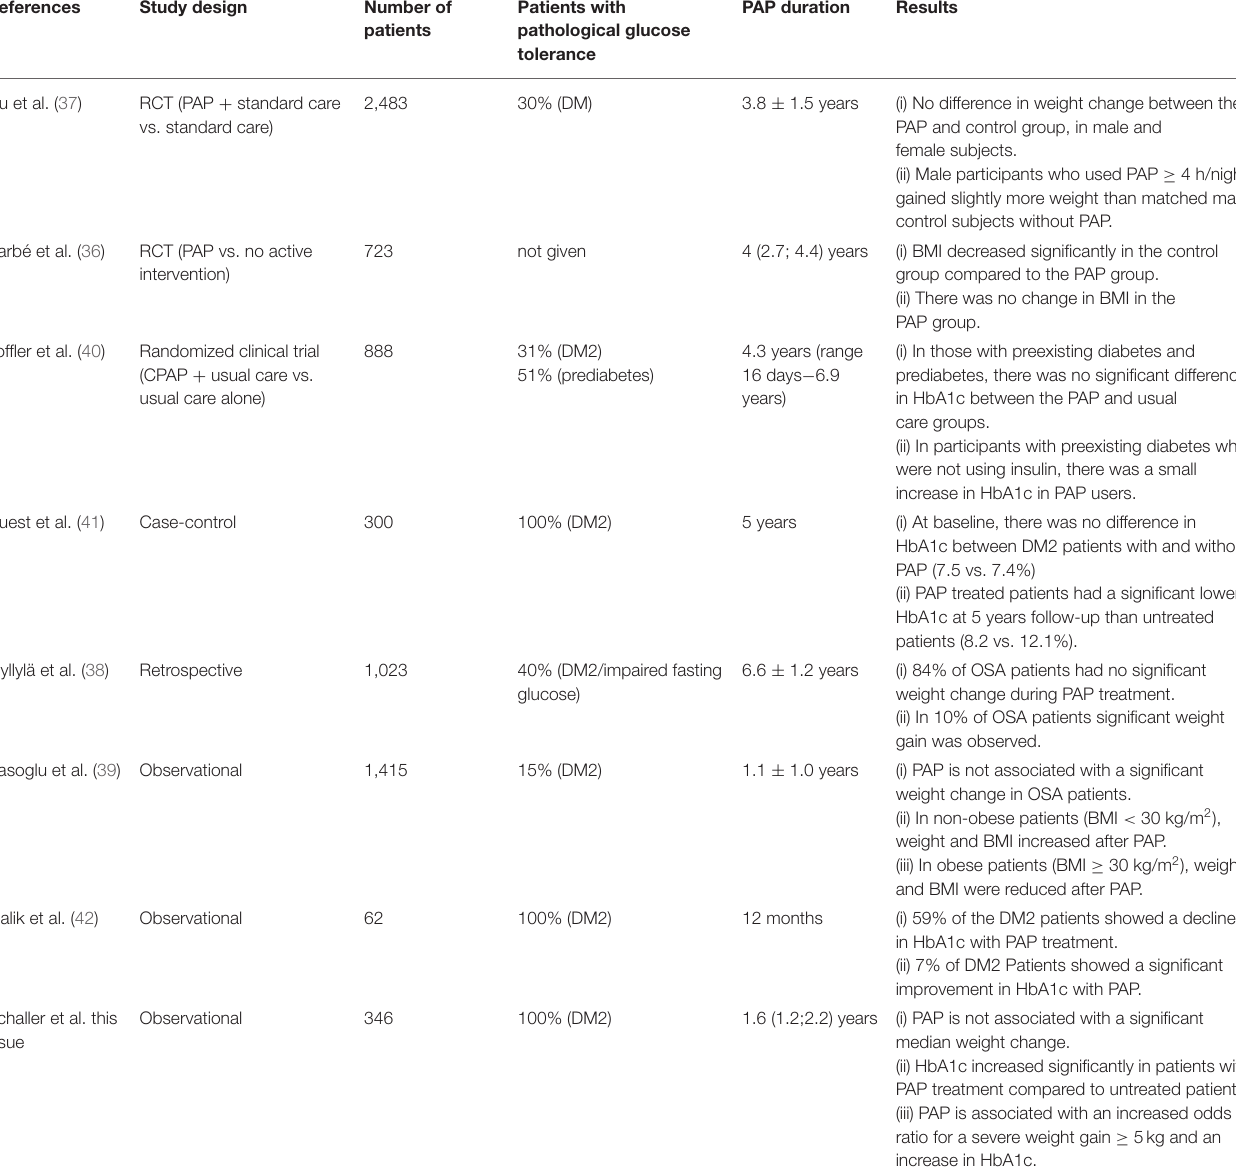
TABLE 5 | Studies investigating changes in weight and glycemic control following PAP